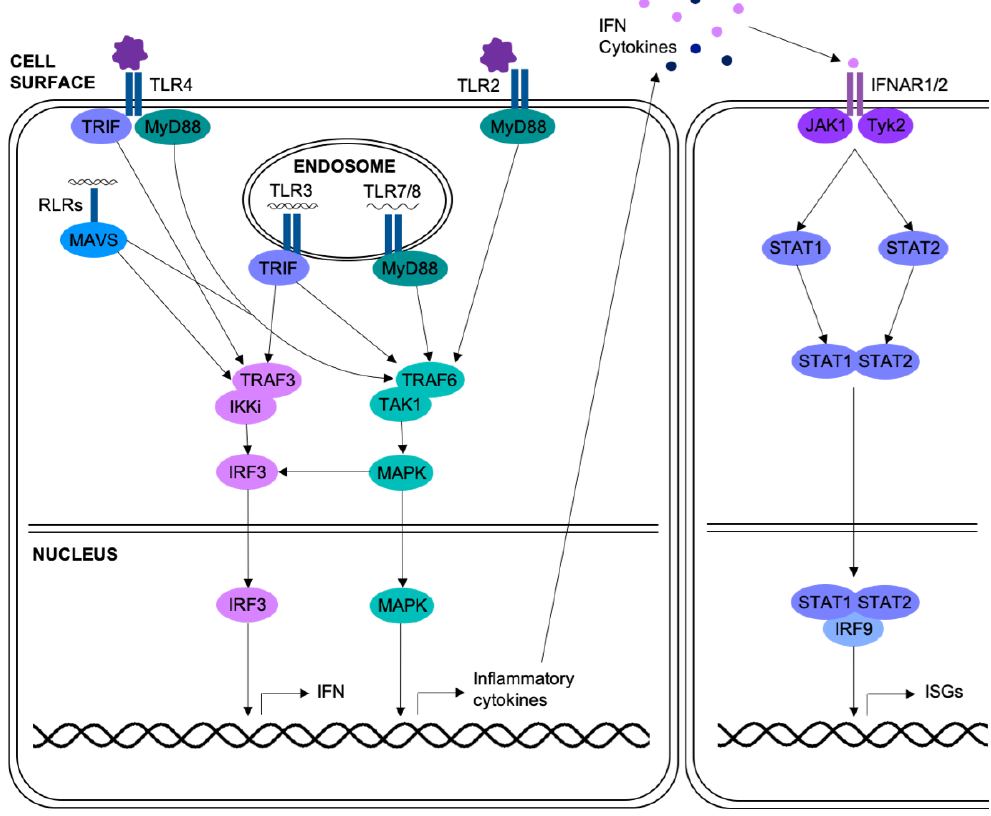
Figure 1. Activation of signaling pathways in respiratory epithelial cells upon viral infection. PRRs detect viral infection of the cell: TLRs 2 and 4 can bind components of the viral surface, TLR3 binds dsRNA, TLR7/8 bind ssRNA, and the RLRs bind dsRNA or 5′-triphosphorylated ssRNA. Adaptor proteins MyD88, TRIF, and MAVS mediate the activation of signaling pathways, including the MAPK pathways. The MAPKs translocate into the nucleus where they activate transcription factors, leading to the transcription of genes for inflammatory cytokines. TRIF and MAVS signaling activates IRF3, leading to interferon production. The MAPK pathways can also activate IRF3. Inflammatory cytokines and interferons are released by the cell and act upon surrounding cells. IFN binds to the IFN receptor complex IFNAR1/2, activating the JAK/STAT pathway. JAK1 and Tyk2 phosphorylate STAT1 and STAT2 which dimerize, translocate to the nucleus and bind IRF9, forming ISGF3, which induces transcription of interferon stimulated genes (ISGs).